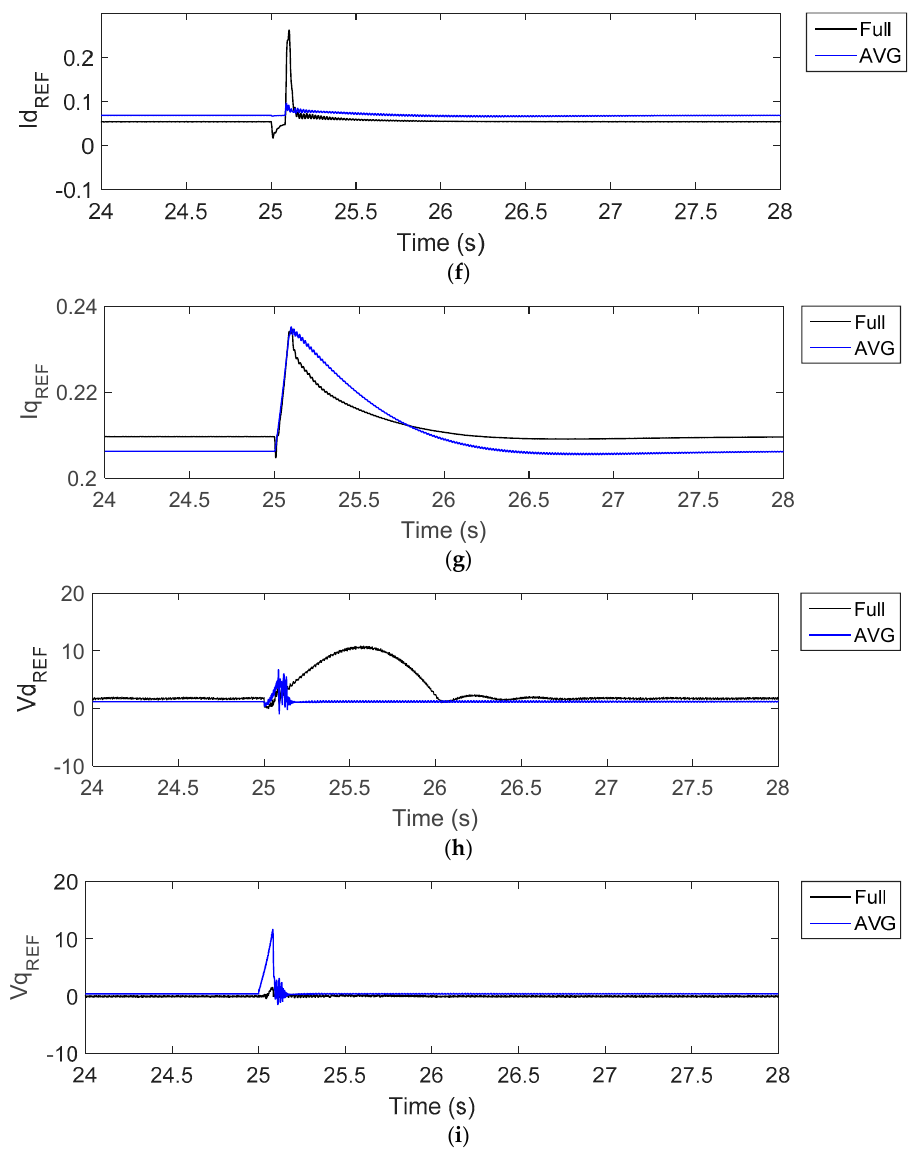
Figure 11. Outputs with 3-phase to ground fault of 0.1 Ω at the DFIG terminal with unbalanced loads: ( a ) active power outputs, ( b ) reactive power outputs, ( c ) load bus voltage, ( d ) DC voltage, ( e ) DFIG speed, ( f ) control reference signals I d at the rotor side, ( g ) control reference signals I q at the rotor side, ( h ) control reference signals V d , ( i ) control reference signals V q .